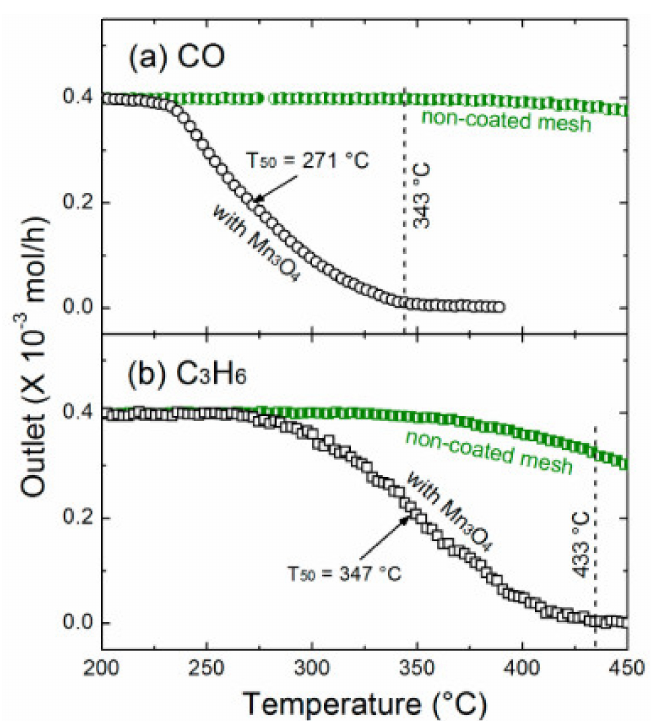
Figure 15. Catalytic test of CO ( a ) and C 3 H 6 ( b ) oxidation with Mn 3 O 4 . As a reference, oxidation of CO and C 3 H 6 was performed on non-coated mesh (reproduced from Ref.